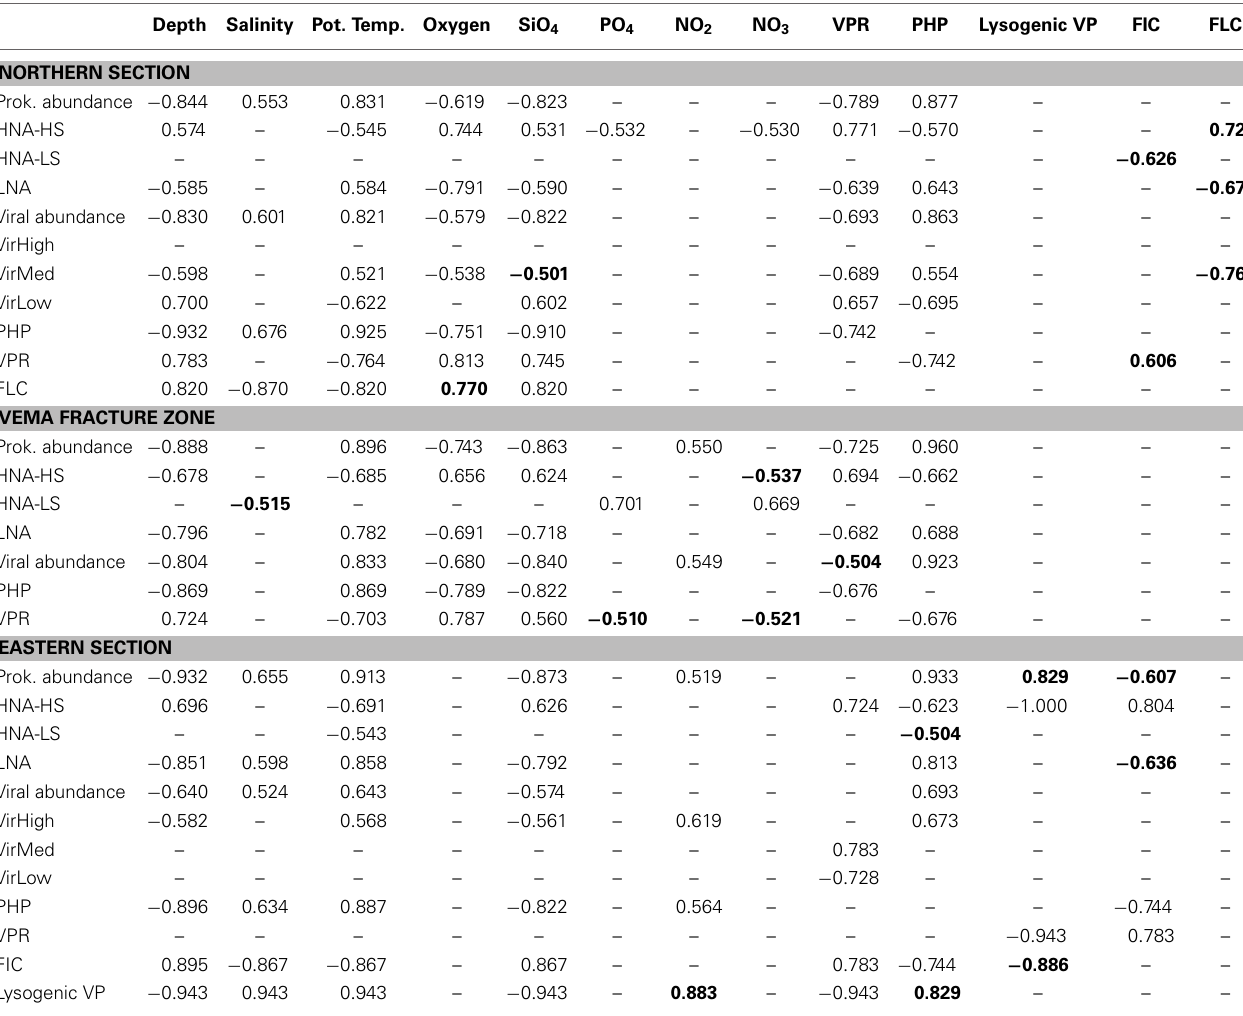
Table 2 | Spearman’s rank correlation coefficients determining the relationship of prokaryotic and viral populations to the physico-chemical parameters measured, prokaryotic and viral production and frequency of infected cells within the three sections (Northern section, Vema Fracture Zone, eastern